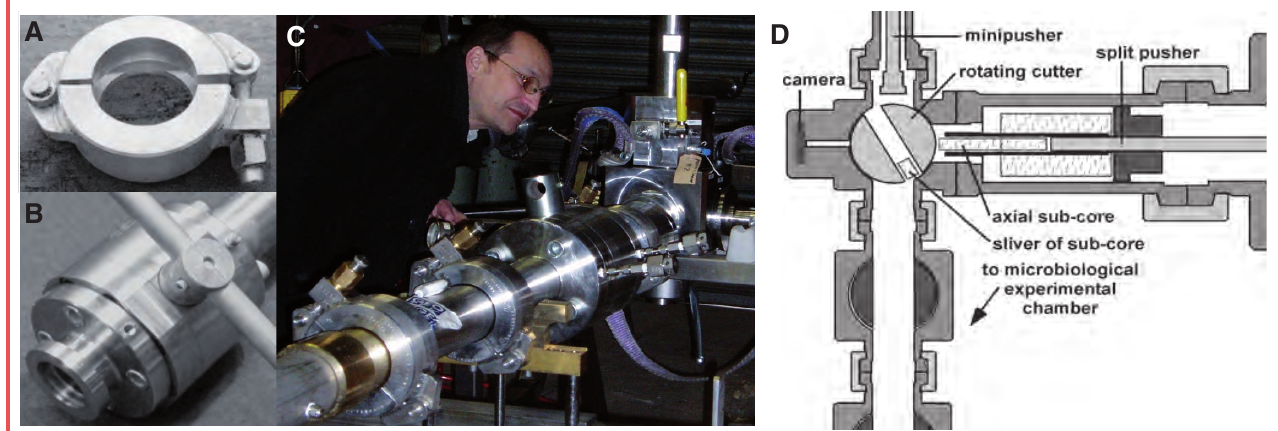
Figure 5. Interfacing third-party equipment to the HYACINTH PCATS. [A] Quick-clamp; [B] ball valve (65 mm internal diameter) and mating flange; [C] the DeepIsoBug, showing ball valves and quick-clamps in use ; [D] diagram of the complex subcoring and sampling mechanism at the heart of the DeepIsoBug. All manipulations are carried out under hyperbaric pressure equivalent to in situ hydrostatic